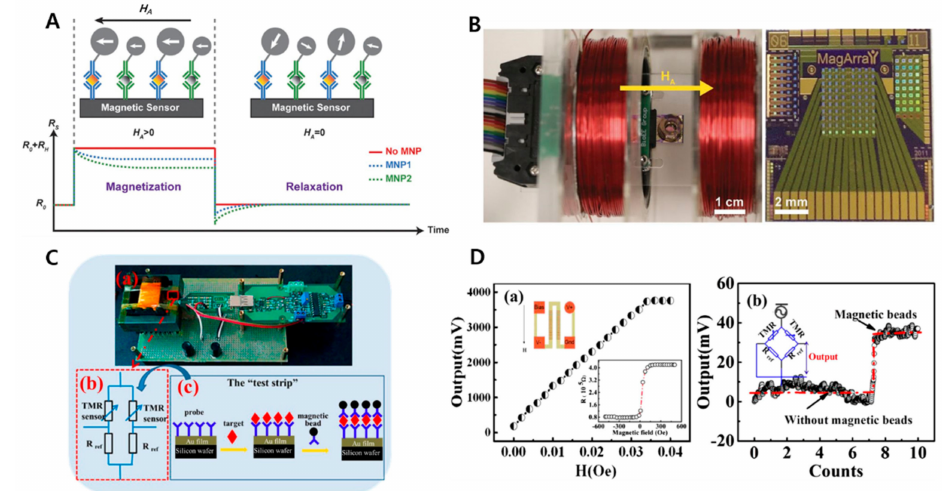
Figure 5. ( A )Illustrationofgiantmagnetoresistance(GMR)biosensorsfortime-domainmagnetorelaxometry with the corresponding resistance signals in response to the external magnetic field; ( B ) simplified measurement setup with electromagnet and sensor array and GMR sensor array; ( C ) the Wheatstone bridge based on tunnel magnetoresistance (TMR) sensors and the sandwich assay on a test strip; ( D ) the results of the system under different magnetic fields, and the real-time response of the system when applying the magnetic beads. Inset: magnetic field dependence on the resistance of a TMR sensor. Reproduced with permission from